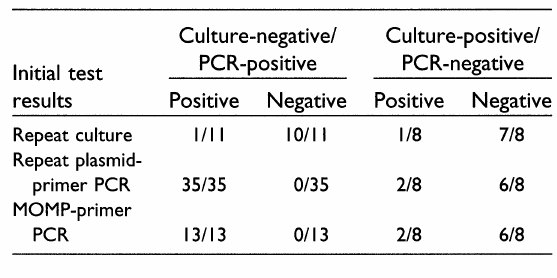
TABLE 4. Results of discrepancy resolution testing in the comparison of culture and PCR-based testing for C. trachomatis